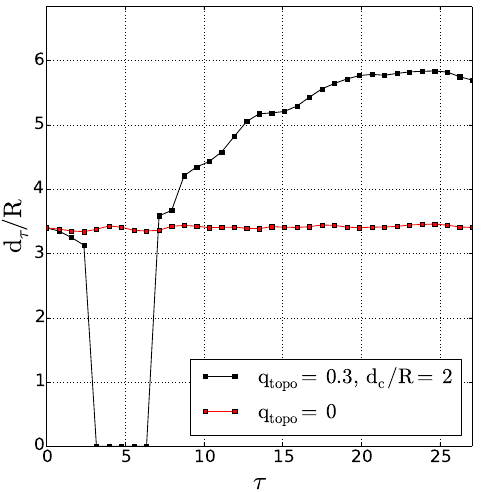
Figure 7. Time evolution of the distance between cyclone centres for the partial merger of two cyclones; case d / R = 3.4, γ R = 1, d c / R = 2; comparison between the evolutions with and without the